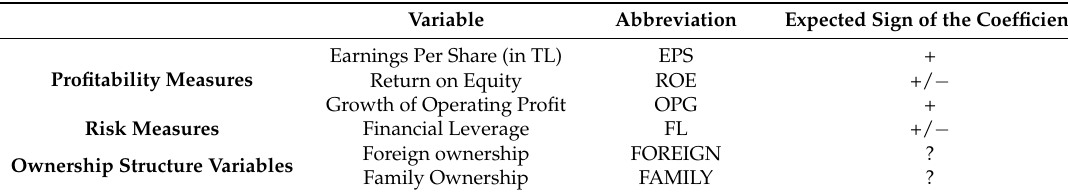
Table 4. Estimation Variables and Expected